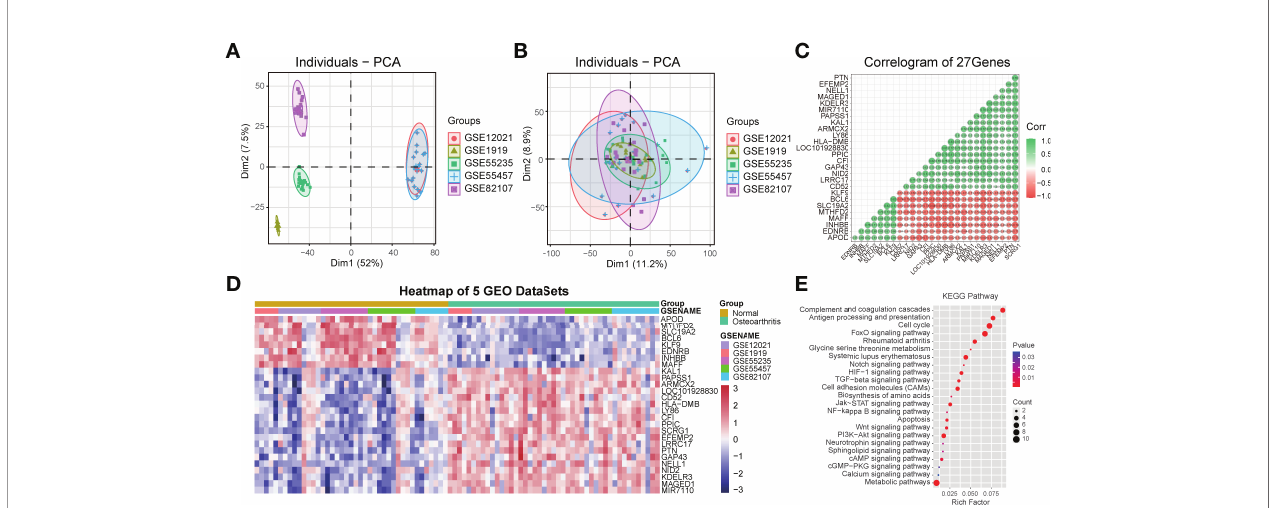
FIGURE 3 | PCA cluster plot before and after sample correction and protein-protein interaction analysis of spearman correlation genes with SCRG1. (A, B) Two- dimensional PCA cluster plot of the 5 microarray datasets before and after sample correction, the colors represent each osteoarthritis datasets. (C) The Spearman ’ s correlation coef fi cients of gene expression with SCRG1, 27 genes were found. (D) Heatmap plot of 27 associated genes, and showed 27 genes also differentially expressed in all synovial tissues and normal tissues. (E) KEGG pathway analysis of the 27 genes, and the enriched immune-related pathways were